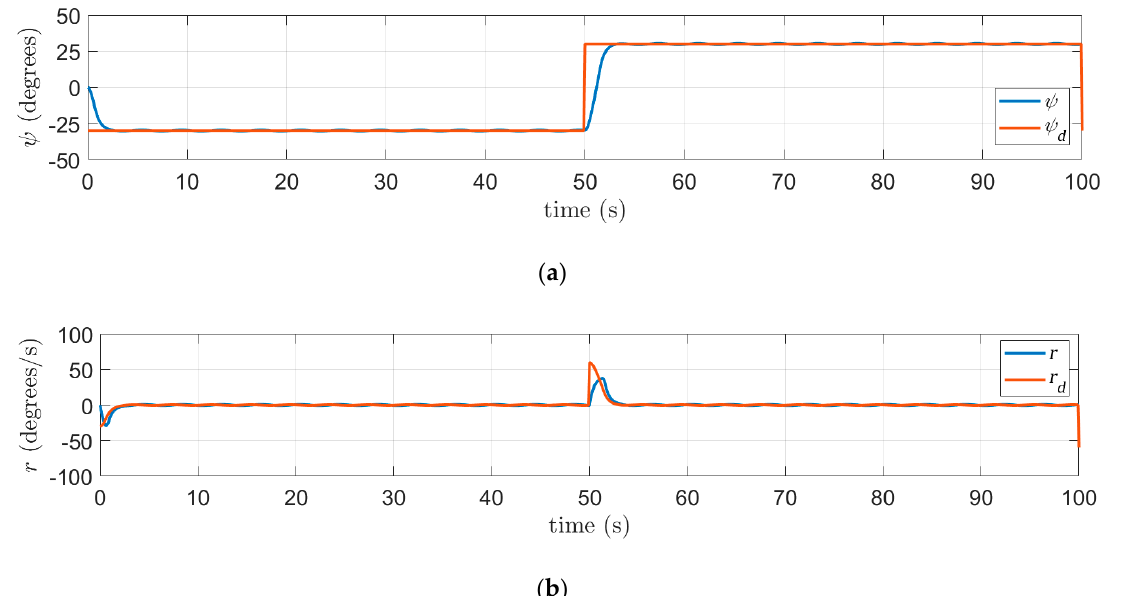
Figure 12. Simulation results of heading performance with robust control. ( a ) Heading angle is regulated to −30° and 30° . ( b ) Yaw rate is regulated at 0 degrees/s.